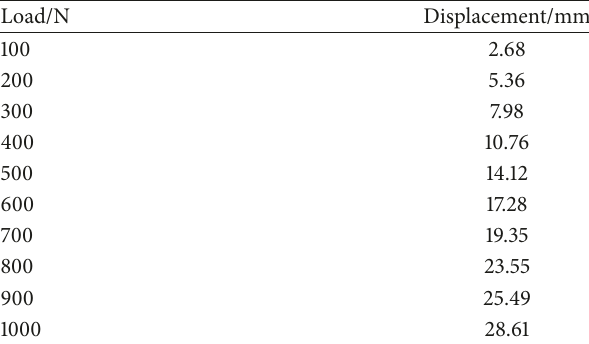
Table 2: Results of the nonlinear static